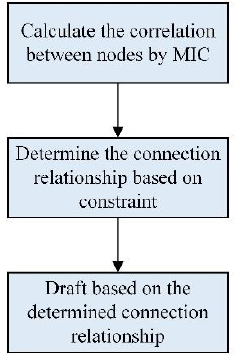
Figure 4. Draft based on constraint.